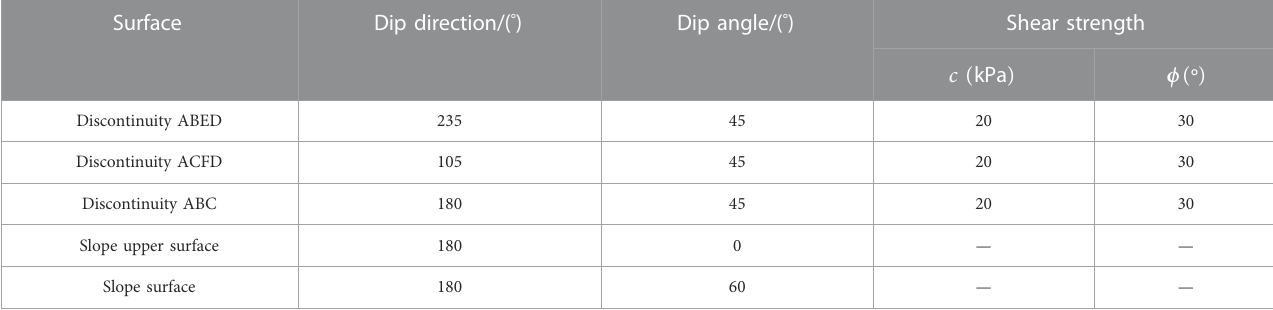
TABLE 4 Geometrical and material parameters of example